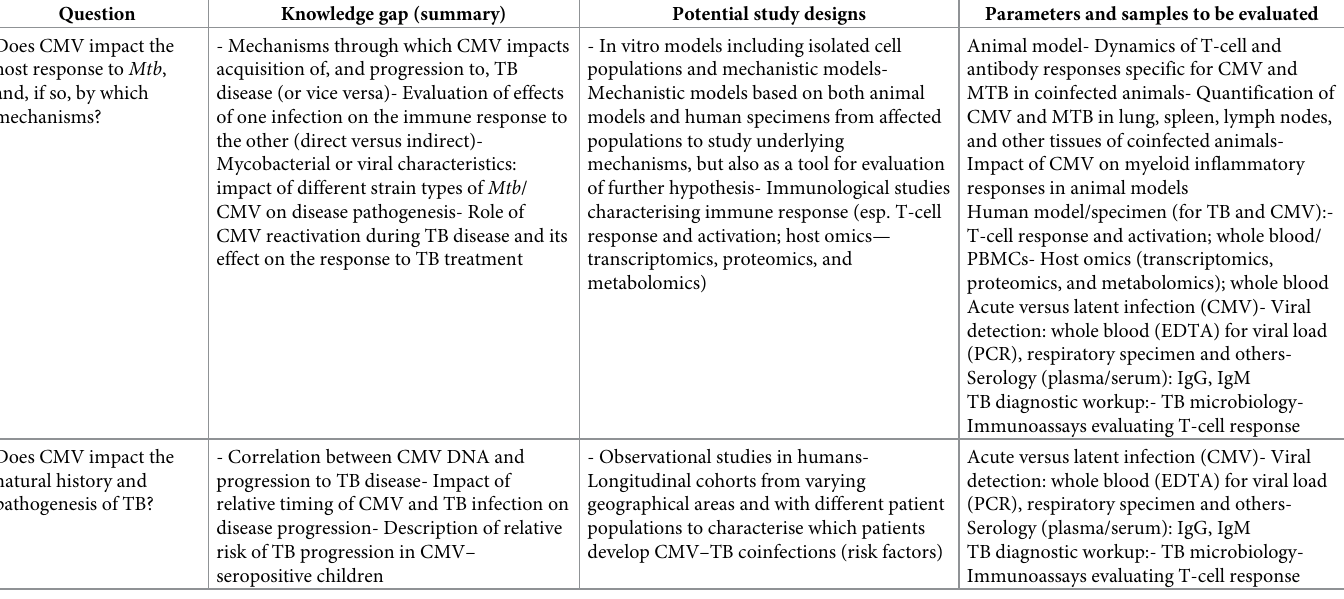
Table 3. Understanding the underlying pathogenesis and immunology of CMV–TB interaction.